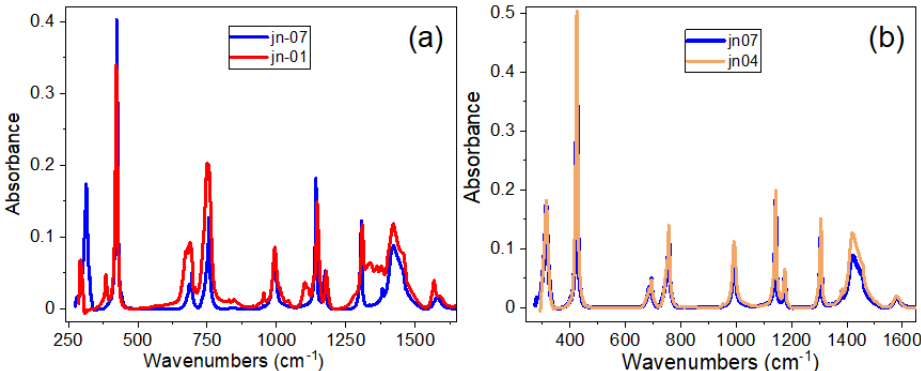
Figure 2. Comparison of FTIR spectra in powder form for samples ( a ) jn ‐ 01 and jn ‐ 07 and ( b ) for samples jn ‐ 07 and jn ‐ 04.